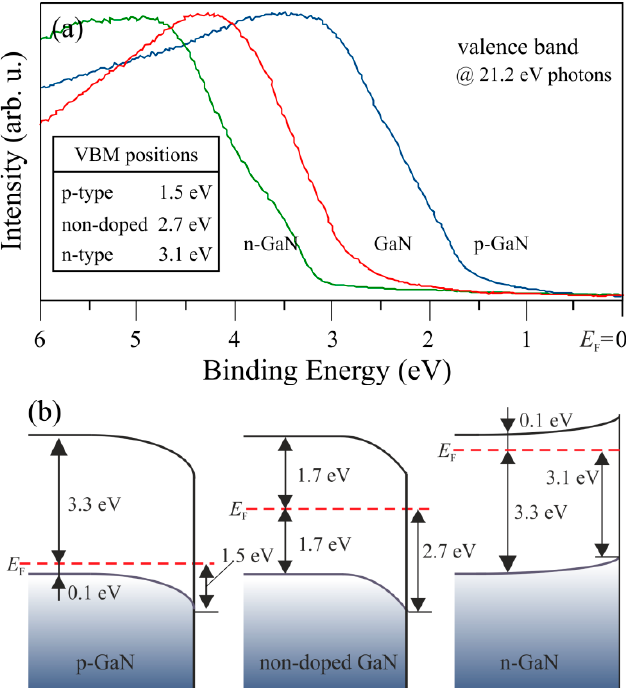
Figure 6. ( a ) Ultraviolet photoelectron spectroscopy (UPS) spectra of the valence band for n ‐ , p ‐ , and nondoped GaN(0001). ( b ) Energy band diagram visualization of ( a ). The Fermi level positions in bulk materials were determined for n ‐ and p ‐ type GaN, with the carrier concentration of 5 × 10 16 and 5 × 10 17 cm − 3 , respectively.